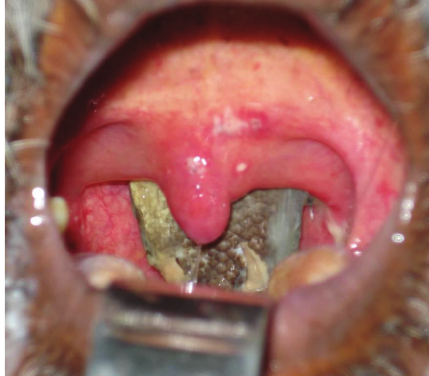
Figure 1: Fish lodged head-up in the patient’s oro-/nasopharynx.